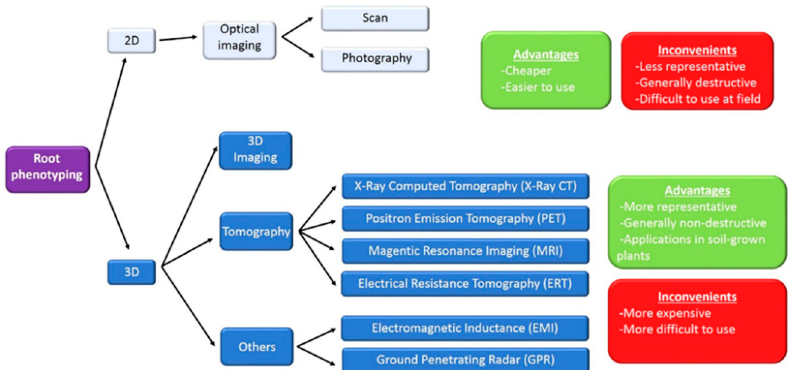
Figure 1. Technologies for root phenotyping. At the top of the figure, classical non-destructive 2D techniques, based on optical imaging, are indicated. Plant root systems are three-dimensional (3D) structures with many features, difficult to quantify in 2D. Advances for phenotyping root architecture in 3D imaging are nowadays available. Non-destructive 3D root phenotyping includes tomographic techniques [X-ray Computed Tomography (X-ray CT); Positron Emission Tomography (PET); Magnetic Resonance Imaging (MRI) and Electrical Resistance Tomography (ERT)]. More recently, two geophysical approaches, Electromagnetic Inductance (EMI) and Ground Penetrating Radar (GPR), have been developed. Advantages and inconvenients of the different technologies are indicated.